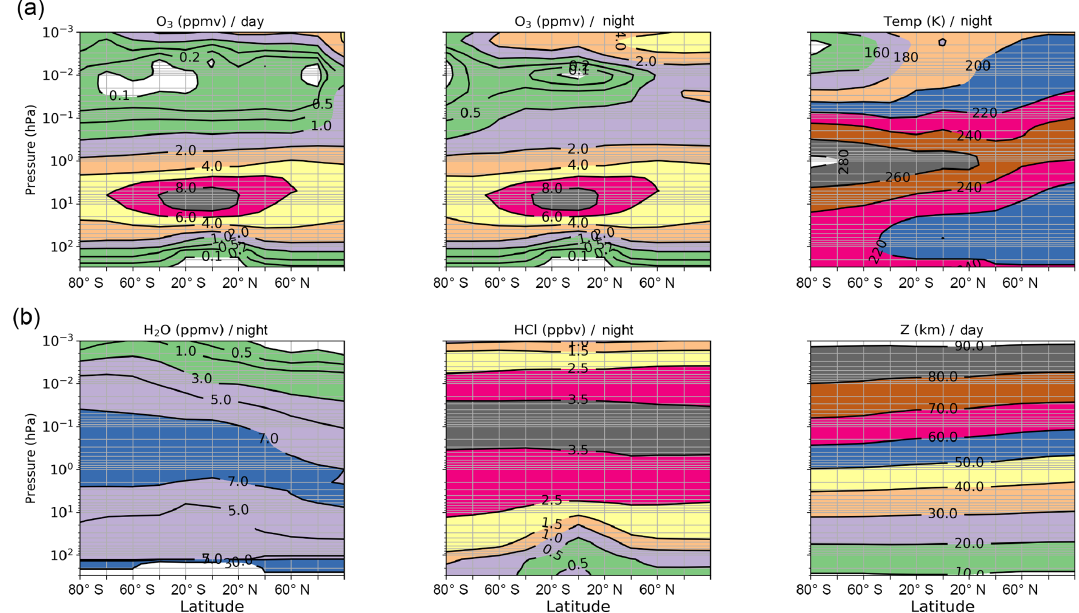
Figure 5. Zonal mean distribution of the most relevant atmospheric parameters for the retrieval error assessment. Images in (a) show the O 3 distributions on pressure levels for day- and night-labeled climatologies as well as the night temperature one. Images in (b) show the night distributions for H 2 O, HCl and geopotential altitude. The white regions indicate values smaller than the color scales.